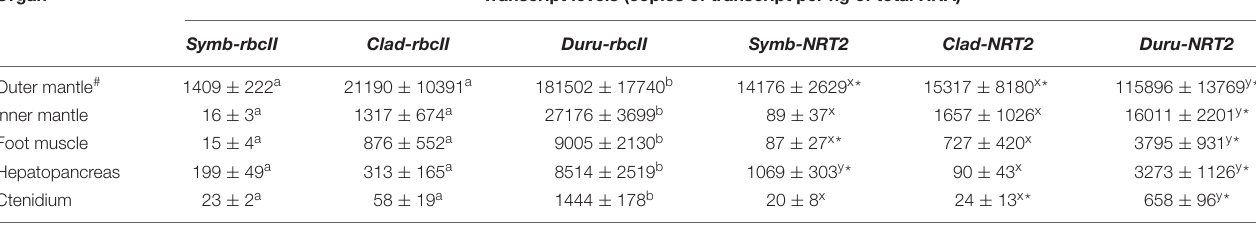
Results are presented as mean ± SEM. Means not sharing the same letter among Symb-rbcII, Clad-rbcII, and Duru-rbcII (a and b) and among Symb-NRT2, Clad-NRT2, and Duru-NRT2 (x and y) are significantly different from each other (p-value < 0.05). *Significantly different between the genus-specific NRT2 and the corresponding genus-specific rbcII of the particular organ (p-value < 0.05). # Refer to Supplementary Table S4 for the transcript levels obtained from the outer mantle in individual